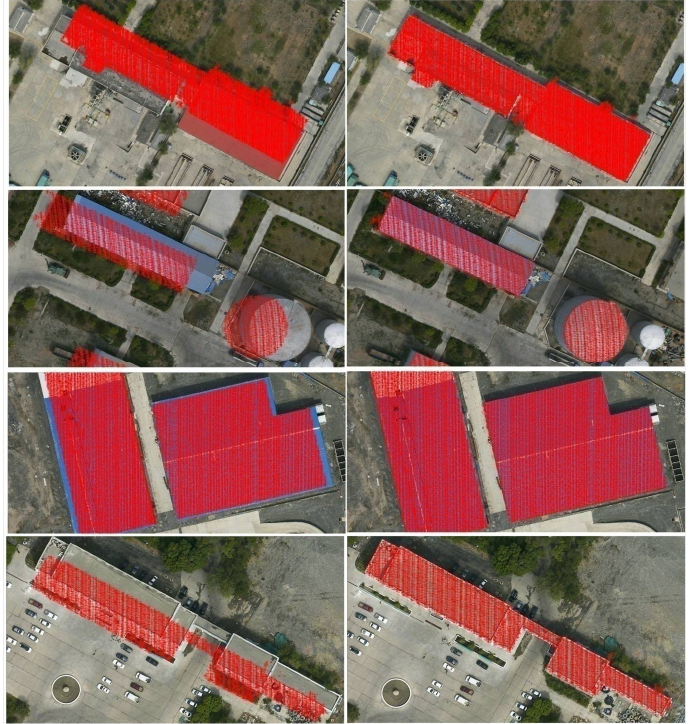
Figure 6. Re-projection of the sub-LiDAR-data to the optical images (Left: before the iterative calculations; Right: after the iterative calculations).